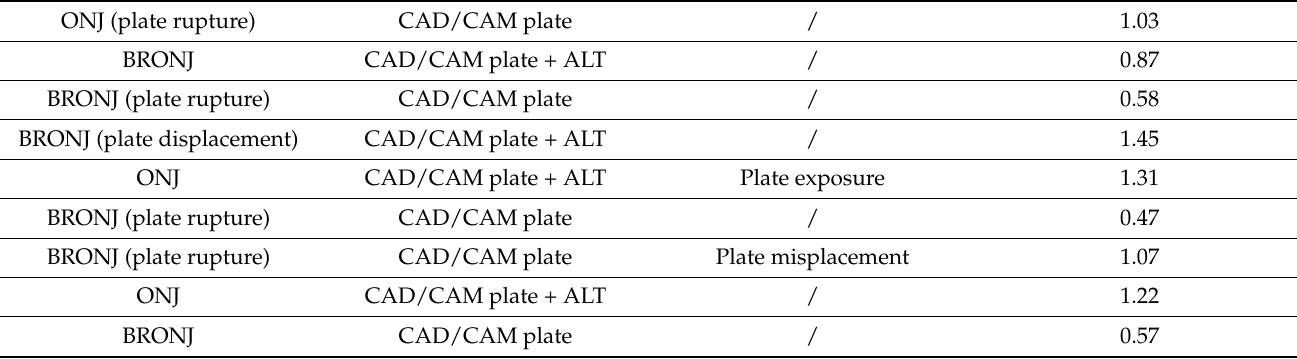
Figure 6. Superimposition and color map of accuracy. Green color represents best accuracy level. In green is displayed the best accuracy between planning and result, in red the worst accuracy obtained. Table 1. Summary of the results of the